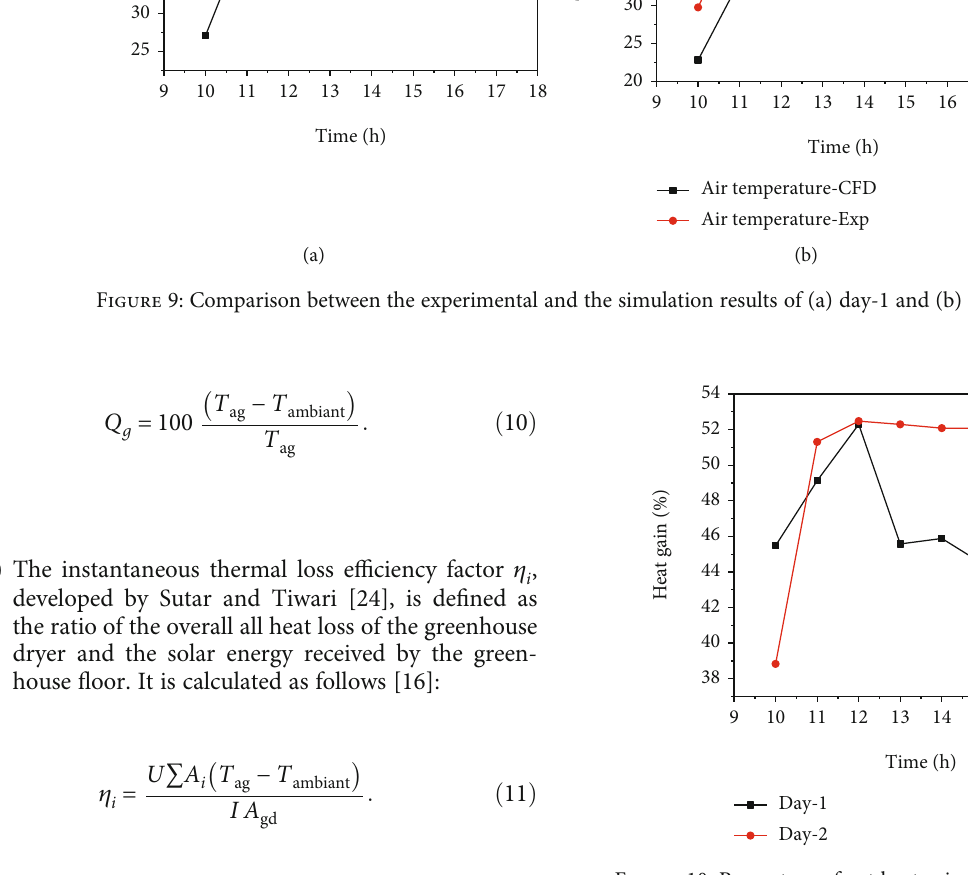
Figure 10: Percentage of net heat gain for day-1 and